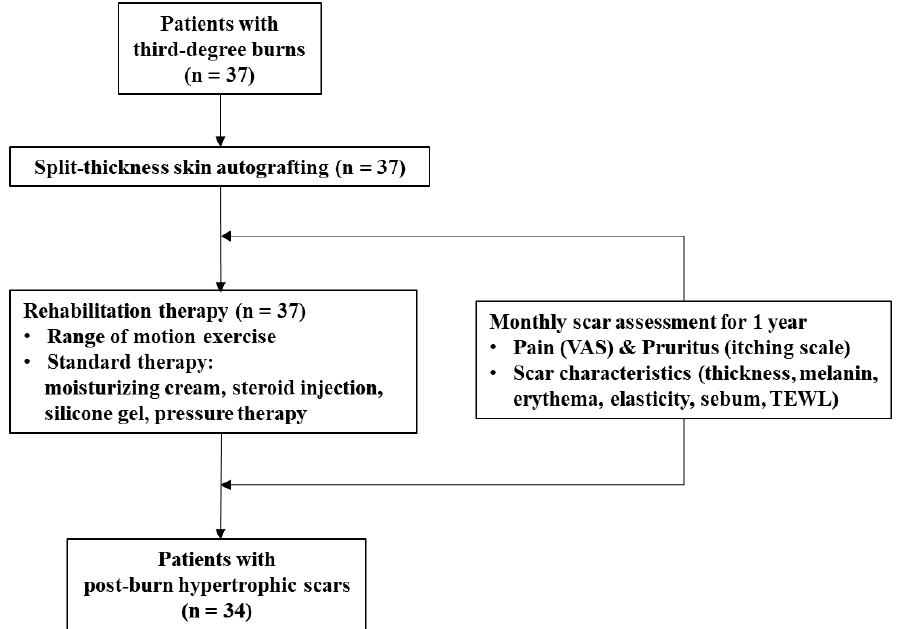
Figure 8. Diagram for patient enrollment and follow-up. VAS: Visual analog scale; TEWL: Transepidermal water loss.